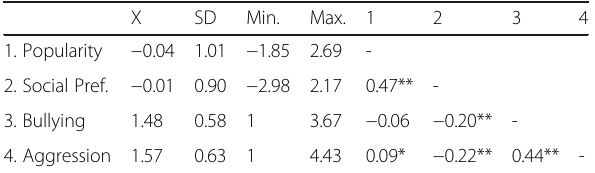
between individual